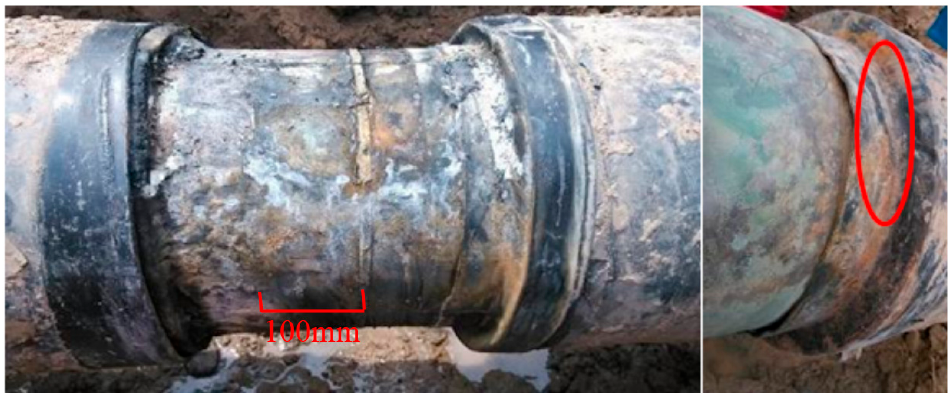
Figure 1. Field joint coating (FJC) failure and cause the pipe body corrosion.